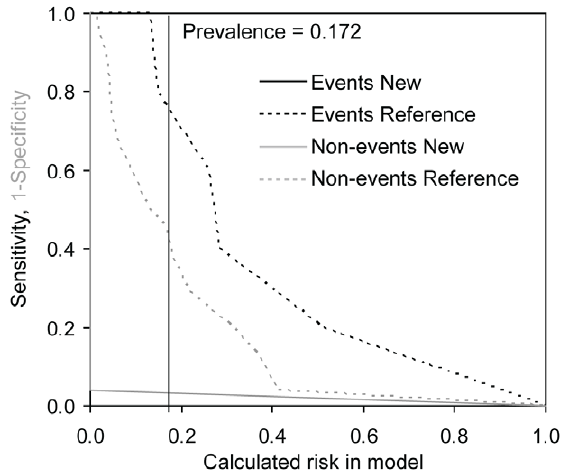
Figure 3. Risk assessment plot of the performance comparison between reference EuroSCORE model and new EuroSCOR- E + MDA model for combined safety endpoint at 30 days in TAVI group (N=29).